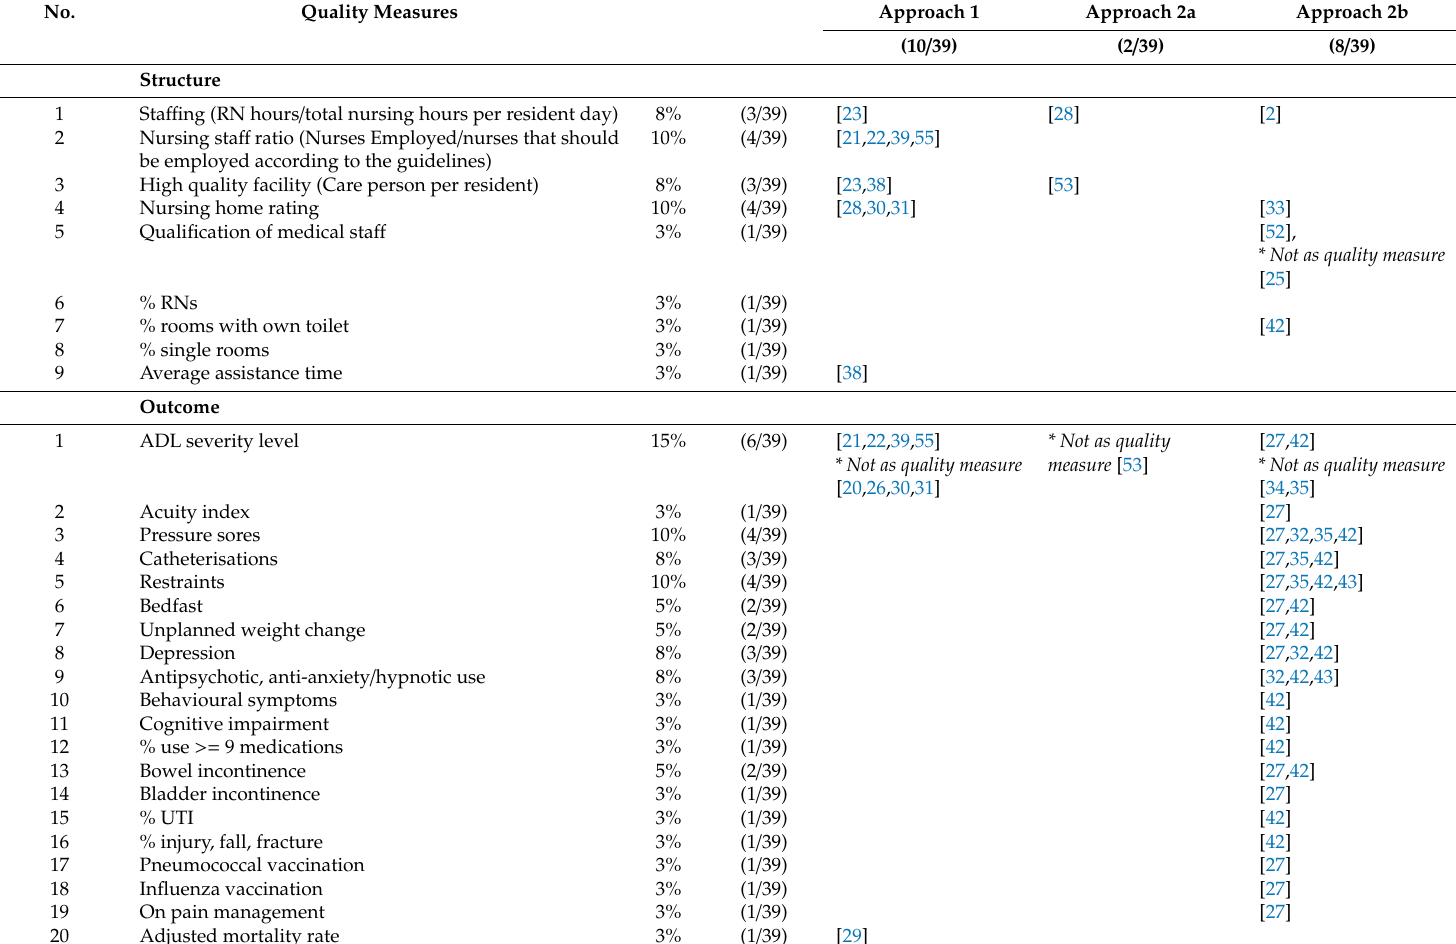
Table 5. Incorporated types of quality indicators into control